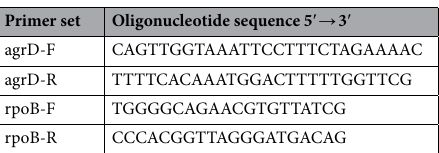
Table 5. Real time-PCR primer sequences designed for this